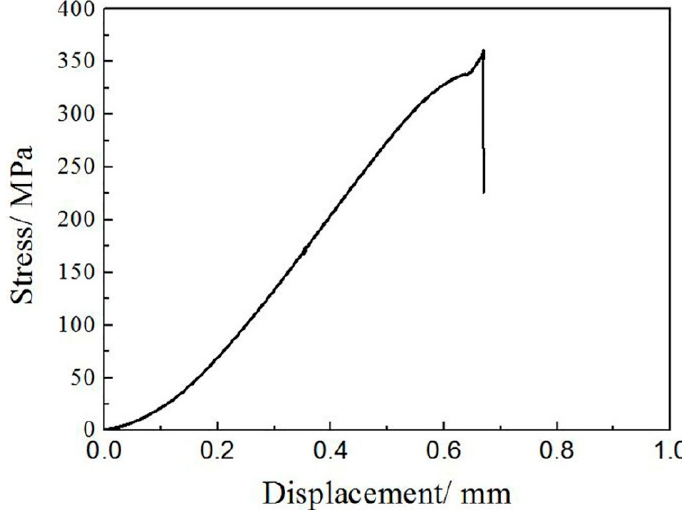
Figure 8. Typical shear stress displacement curve of TA1/LAS composite plate achieved from shear tests.